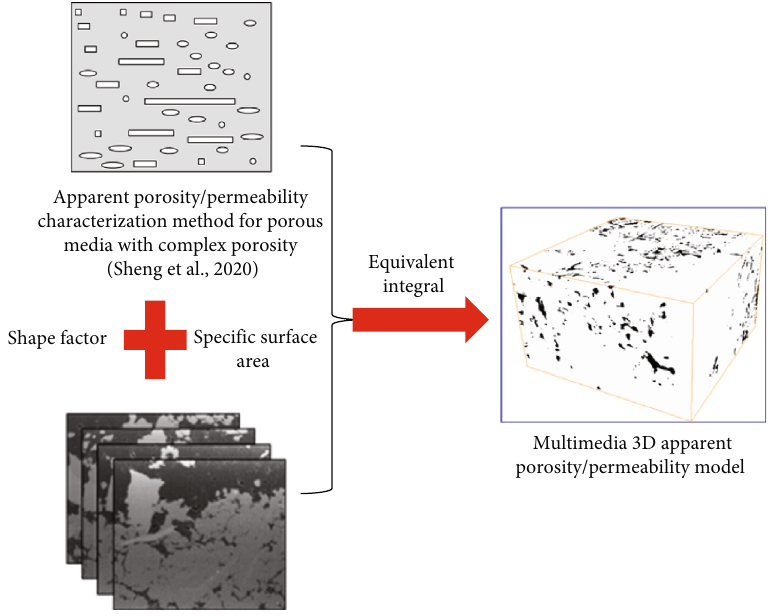
Figure 4: Approach for apparent porosity/permeability modeling of Complex porous media